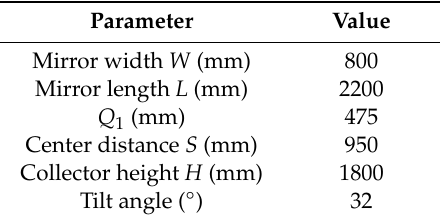
Table 5. Parameters of the Fresnel solar